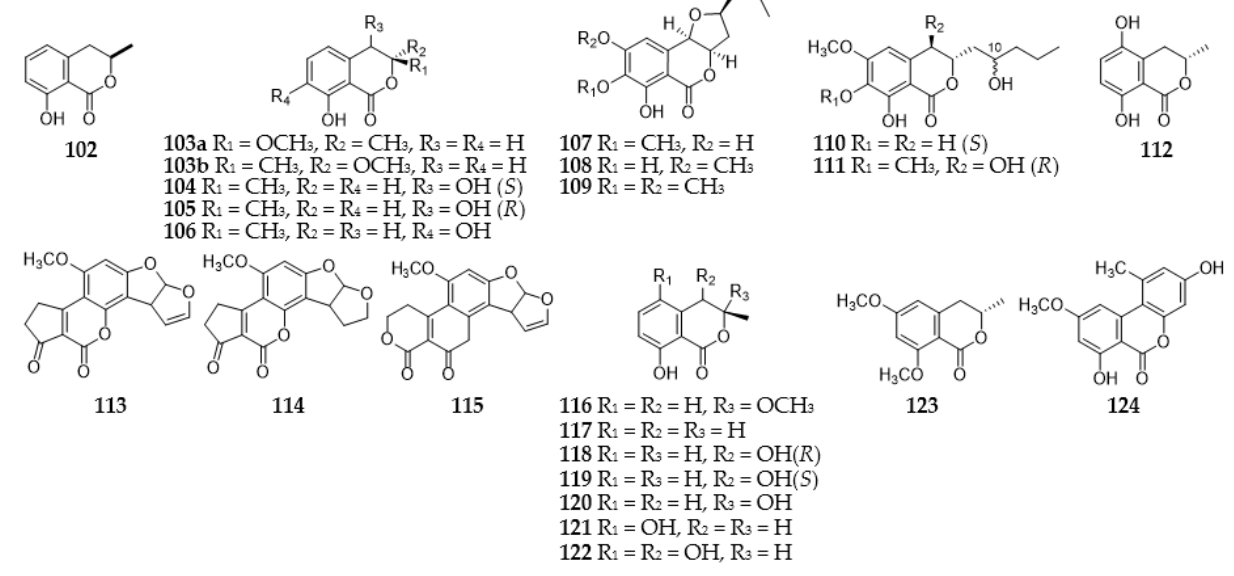
Figure 7. Aspergillus -derived isocoumarins ( 102 – 124 ).